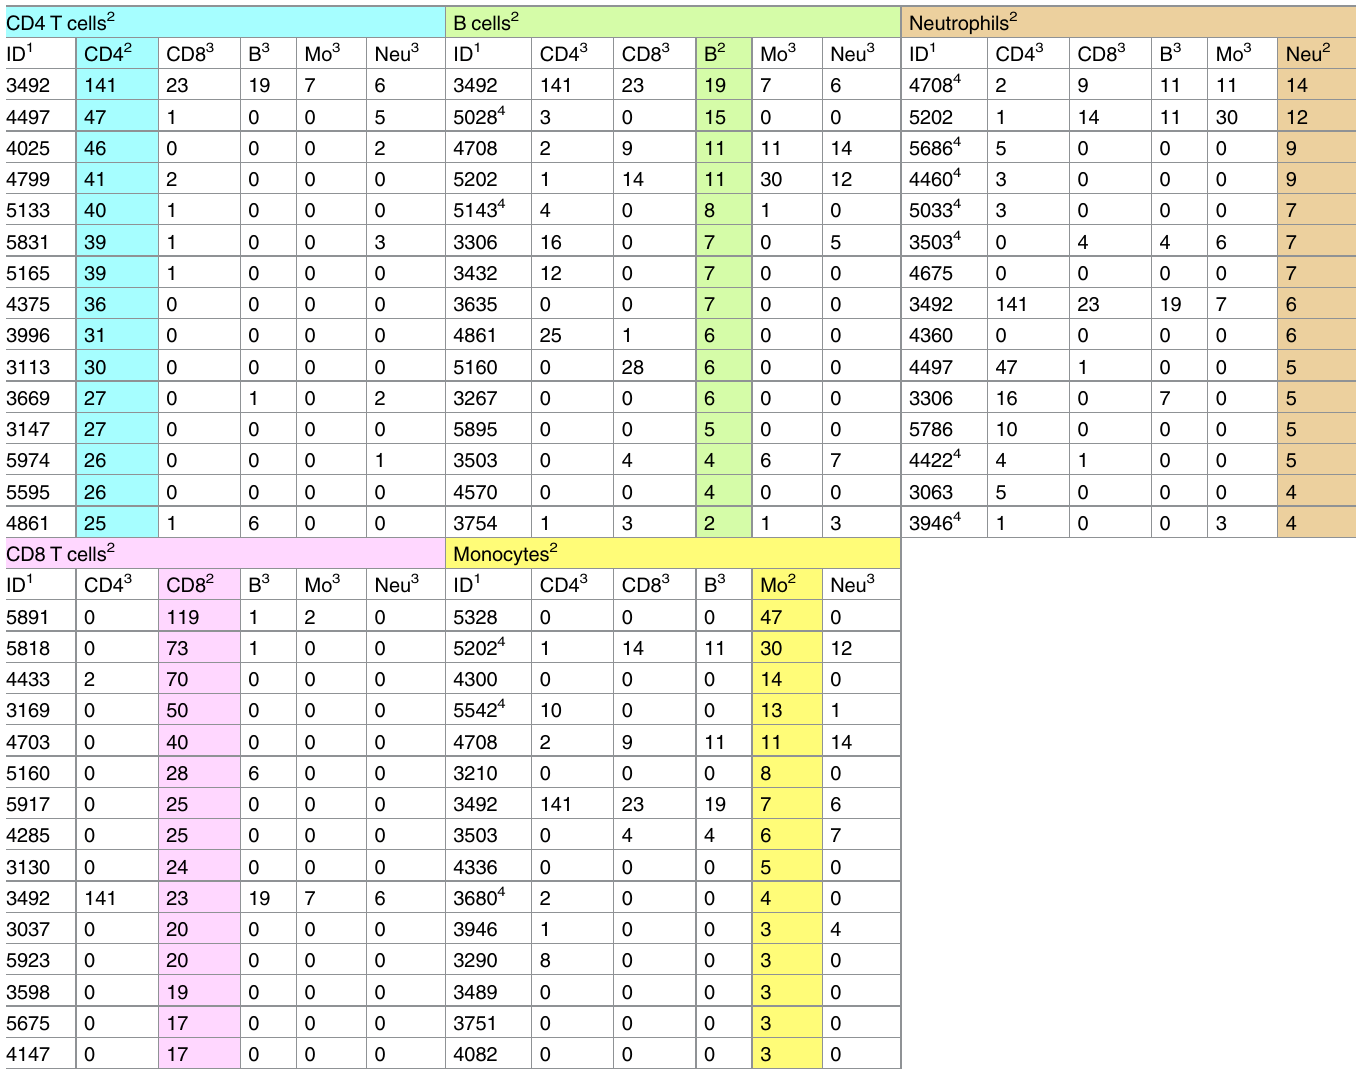
Table 1. Top 15 clones of each cell lineage in HAM/TSP#2. CD4 T cells